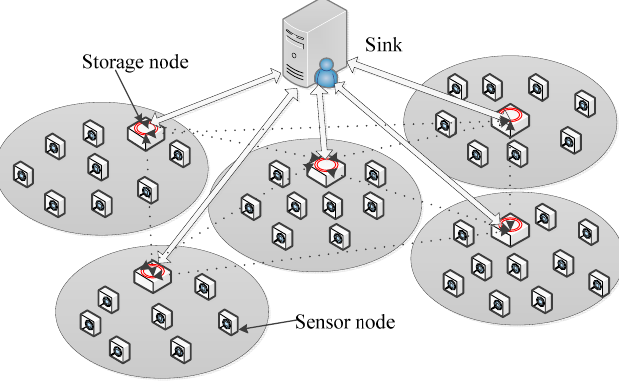
Figure 1. Architecture of two-tiered Wireless Sensor Networks.